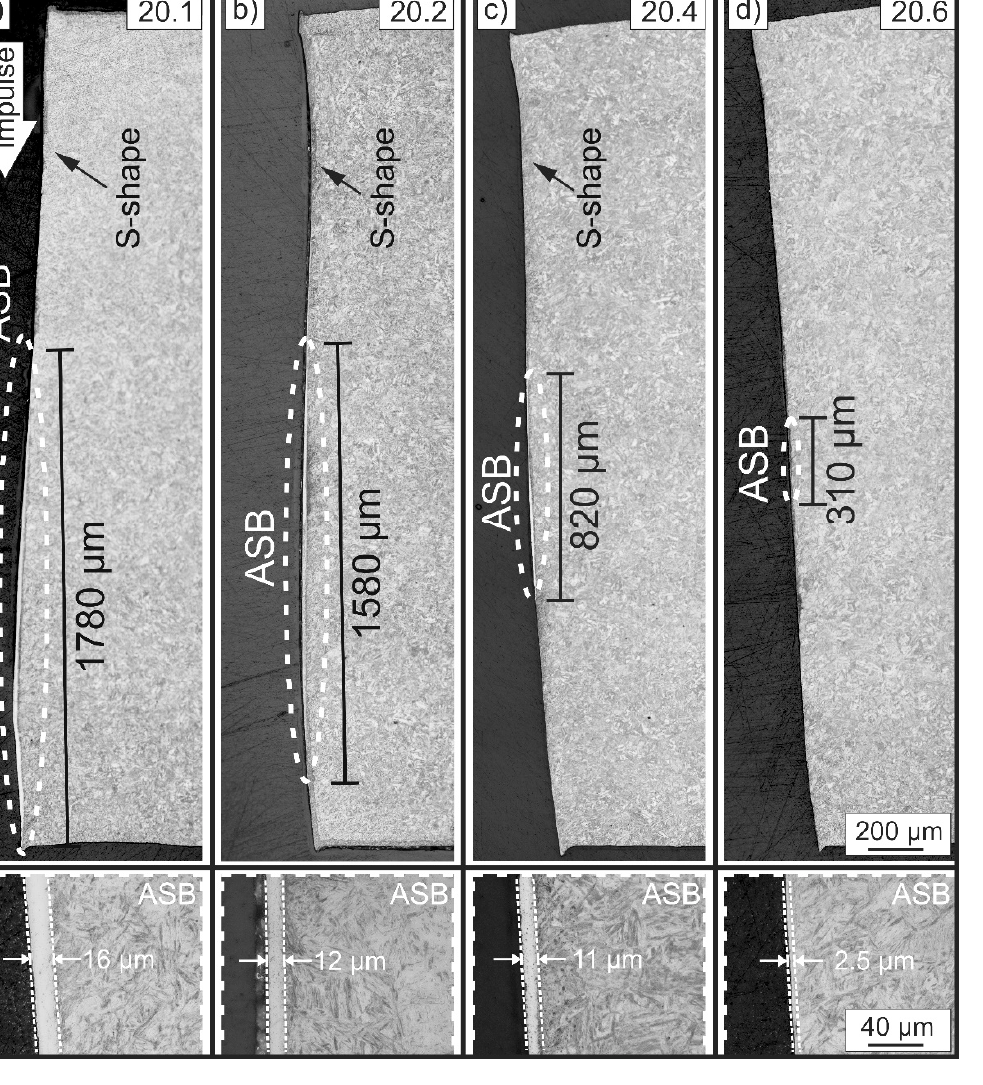
Figure 3. Blanked surface of the sheet for 1000 J impact energy and a relative clearance of ( a ) 1.67%, ( b ) 3.34 %, ( c ) 6.67% and ( d ) 10.00%. With decreasing blanking clearance, the adiabatic shear band (ASB) becomes longer and wider.